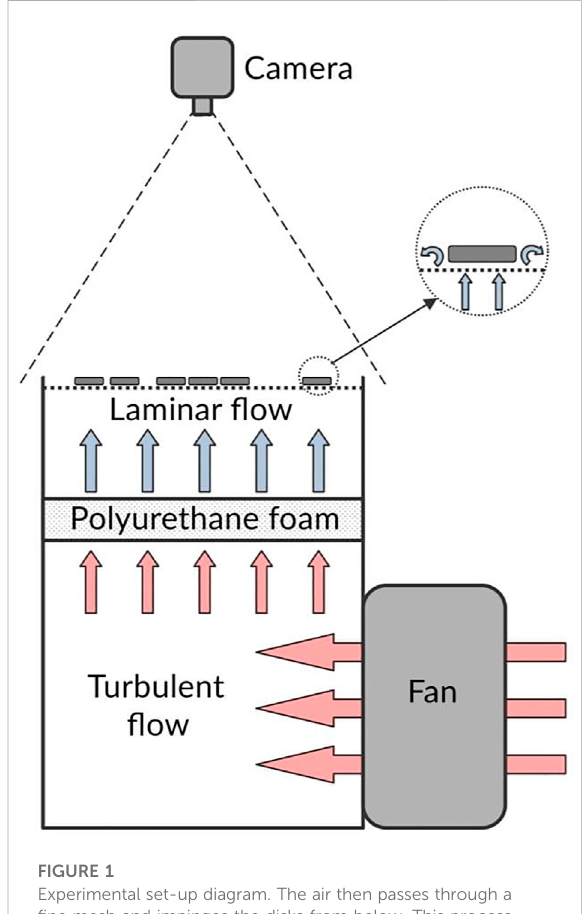
FIGURE 1 Experimental set-up diagram. The air then passes through a fi ne mesh and impinges the disks from below. This process simultaneously yields stochastic translation and a systematic rotation on the particles. We acquire images by means of a high speed camera mounted above the